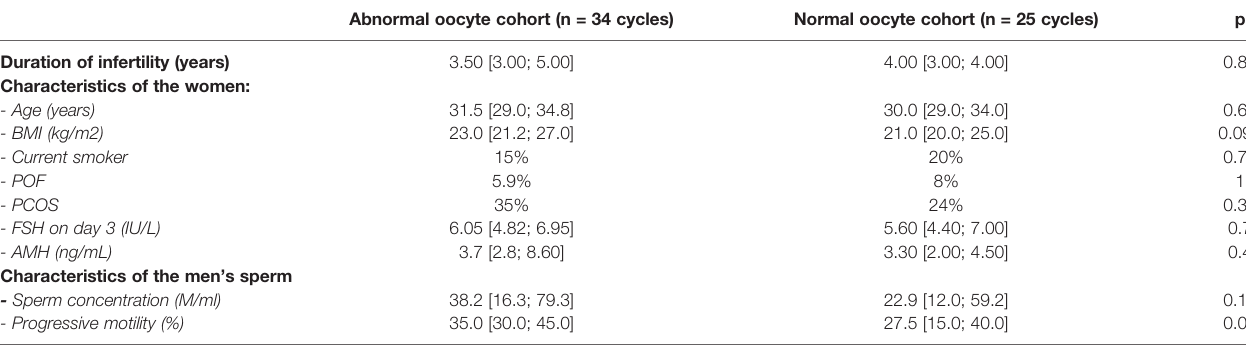
TABLE 1 | Characteristics of the study population, as a function of the oocyte cohort quality. Abnormal oocyte cohort (n = 34 cycles) Normal oocyte cohort (n = 25 cycles)